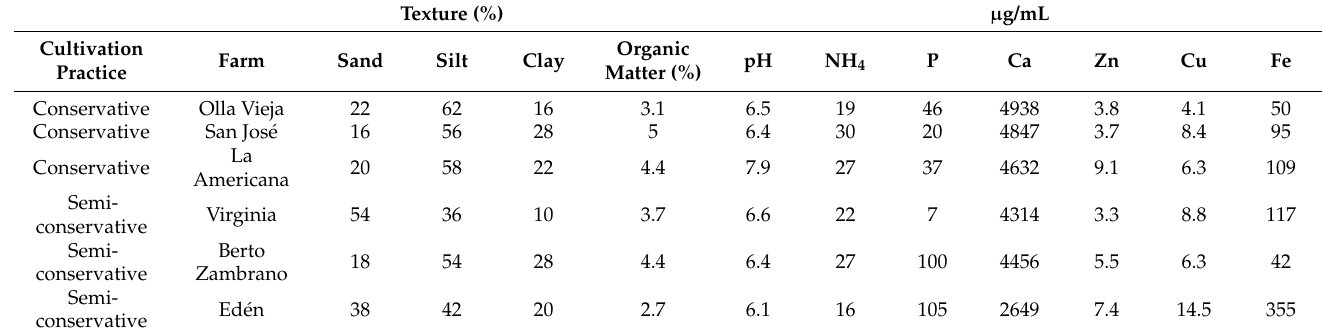
Table A3. Analysis of the physicochemical properties of the soil from cocoa crops under two cultivation practices.